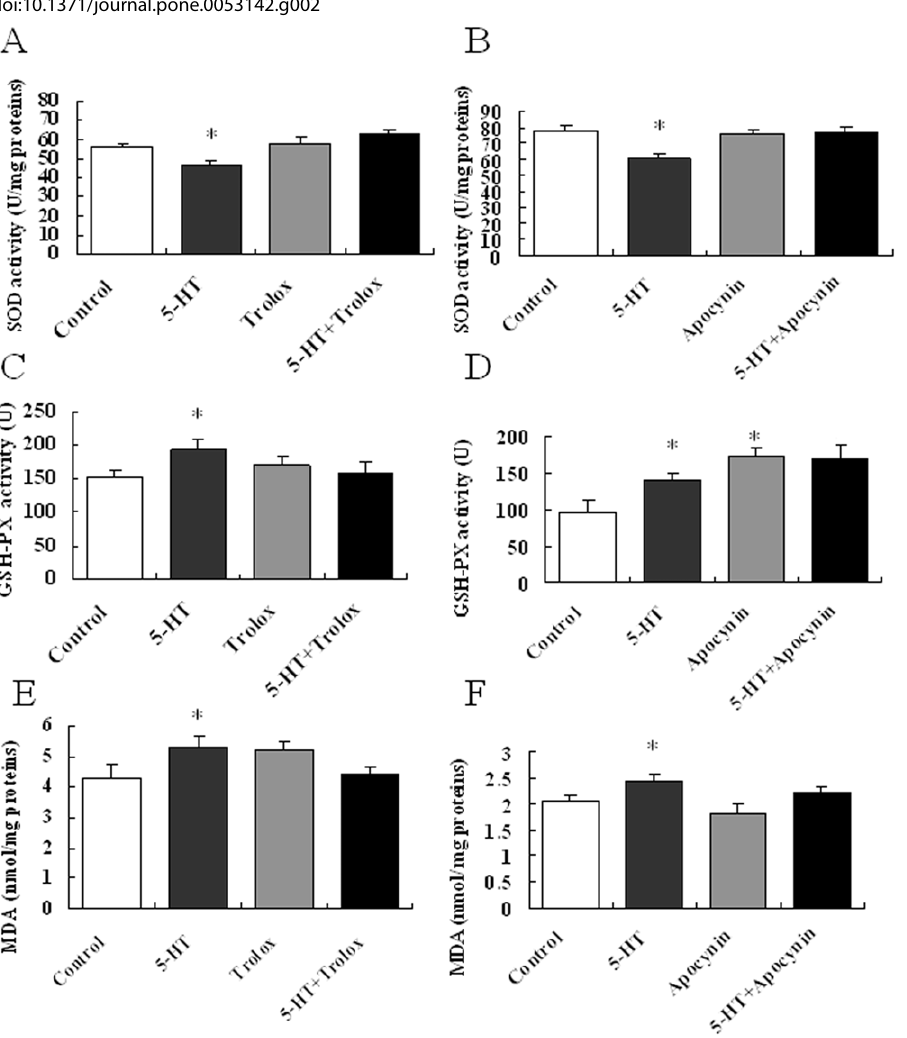
Figure 3. Effects of 5-HT on the activities of SOD and GSH-PX and on the MDA content in the hypothalamus. The total hypothalamic activities of SOD (T-SOD) and GSH-Px, as well as the malondialdehyde (MDA) levels, were determined using colorimetric assays. (A–B) Hypothalamic total SOD activity. n=8–12 per group. (C–D) Hypothalamic GSH-PX activity. n=8–12 per group. (E–F) Hypothalamic MDA content. n=8–12 per group. Data are expressed as the means 6 SEM. *, 0.01 , p , 0.05, vs. the control.